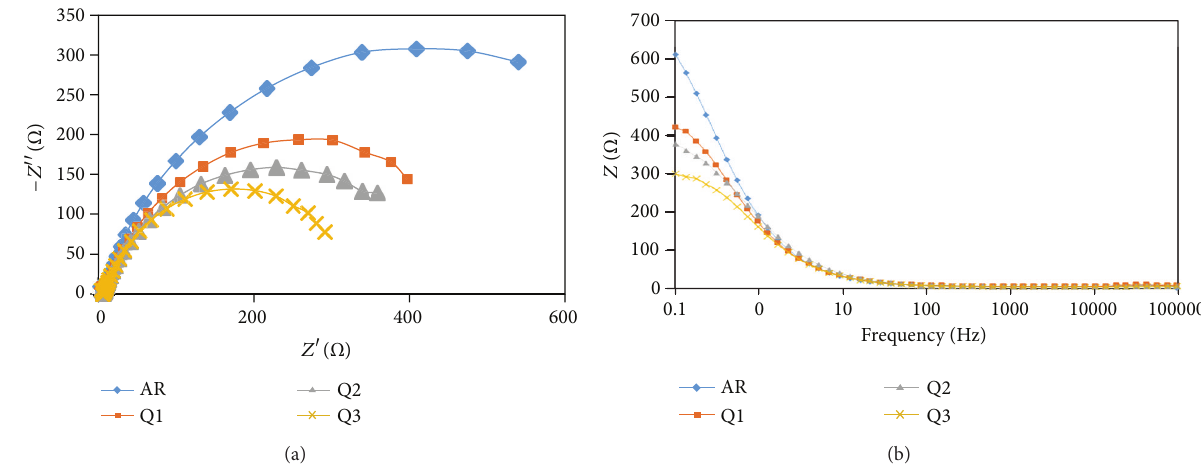
Figure 4: Electrochemical Impedance curves (Nyquist and Bode) for microalloy steel samples in 3.5% NaCl at room temperature (AR-as received, Q1-first quench, Q2-second quench, and Q3-third quench).